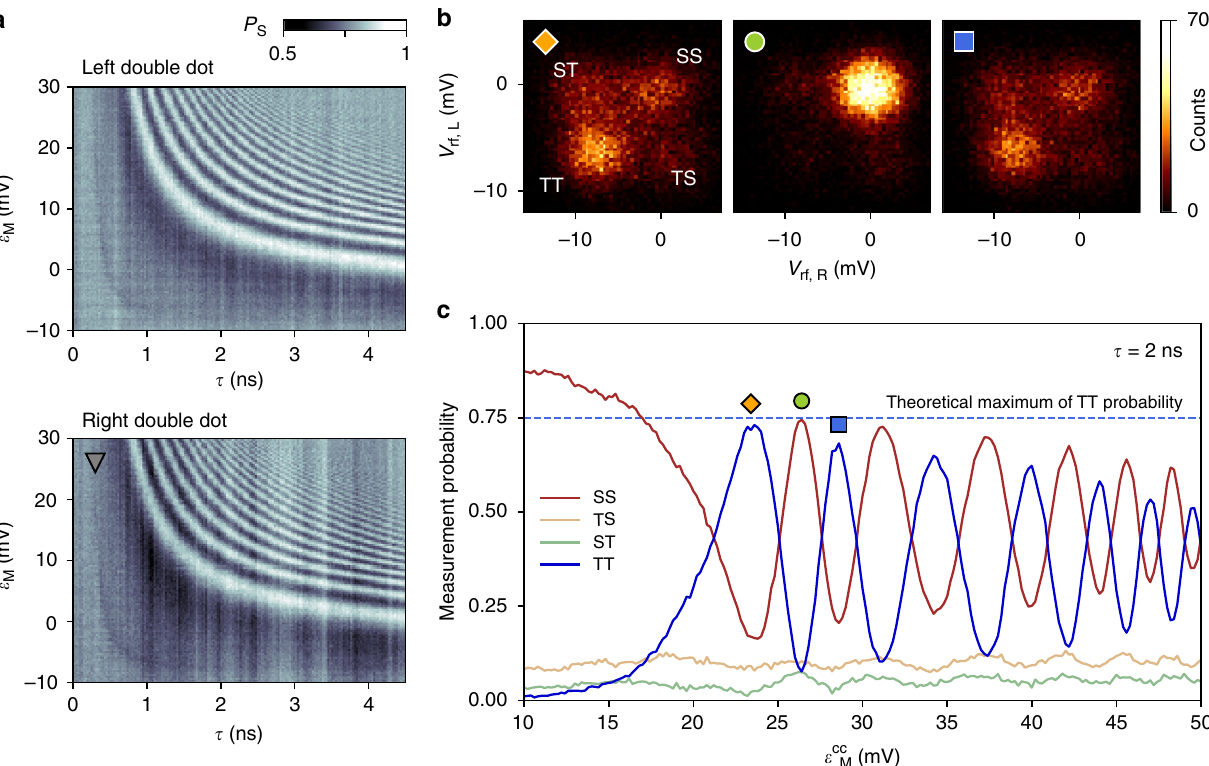
Fig. 2 Exchange oscillations across the mediator and non-local correlations. a Fraction of detected singlet outcomes, P S , acquired simultaneously for the left and right double dot, as a function of interaction time τ and pulse amplitude ε M . The choice of detuning between inner dots, ε = − 2 mV, corresponds to a symmetric operation point (cf. gray triangle in Fig. 3b). b Histograms of demodulated sensor voltages, when repeating a pulse cycle with τ = 2 ns many times, for three different choices of ε cc as marked in panel ( c ). Counts bunch into four groups, each associated with a different combination of singlet (S) or M triplet (T) measurement outcomes for the two double dots. Correlations within these single-shot measurement outcomes reveal the non-local nature of the interaction. c Joint probabilities of all four possible joint outcomes, as a function of the exchange-inducing pulse amplitude ε cc for fi xed interaction time τ = M 2 ns. Here, ε cc -pulses are de fi ned similarly to ε M -pulses, but with a different choice for the cross-compensation amplitudes (see Supplementary Note 1). M Dashed line indicates the largest expected probability to detect TT for the maximally entangled state (see